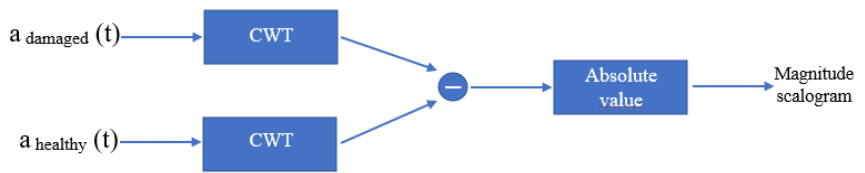
Figure 5. Scheme illustrating the way in which the CWT was used in the present